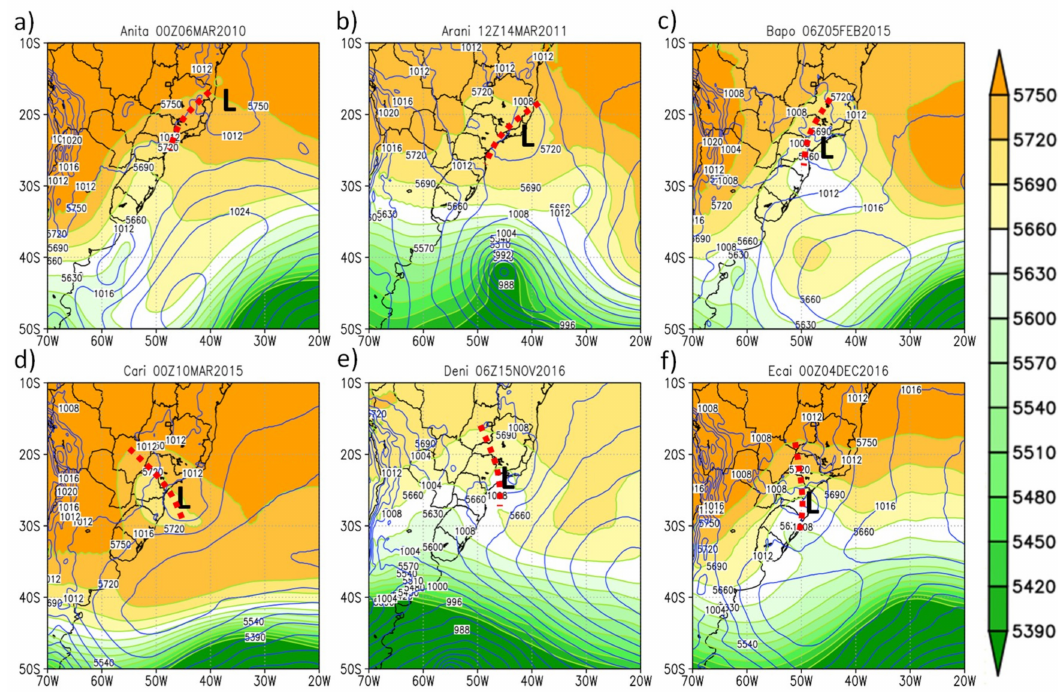
Figure 4. Geopotential height (m) at 500 hPa (shaded and green line) and mean sea-level pressure (hPa; blue lines) during the genesis phase of the six subtropical cyclones: ( a ) Anita, ( b ) Arani, ( c ) Bapo, ( d ) Cari, ( e ) Deni and ( f ) Eça í . L indicates the surface low-pressure center and the red dashed lines show the trough axis at 500